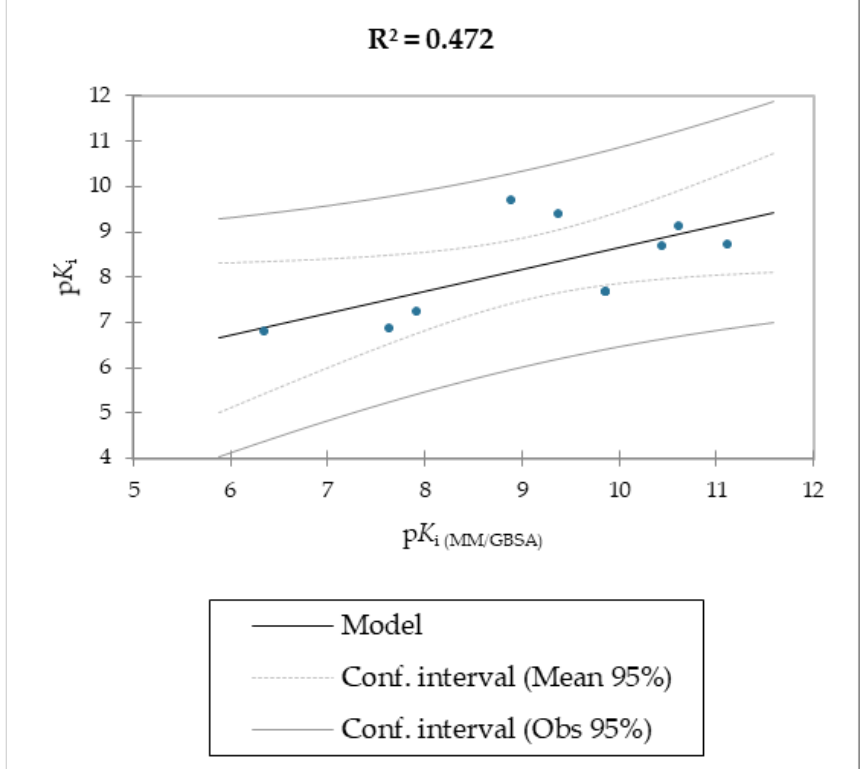
Figure 6. Calculated p K i with MM/GBSA method vs. experimental p K i of molecules 1 – 9 .